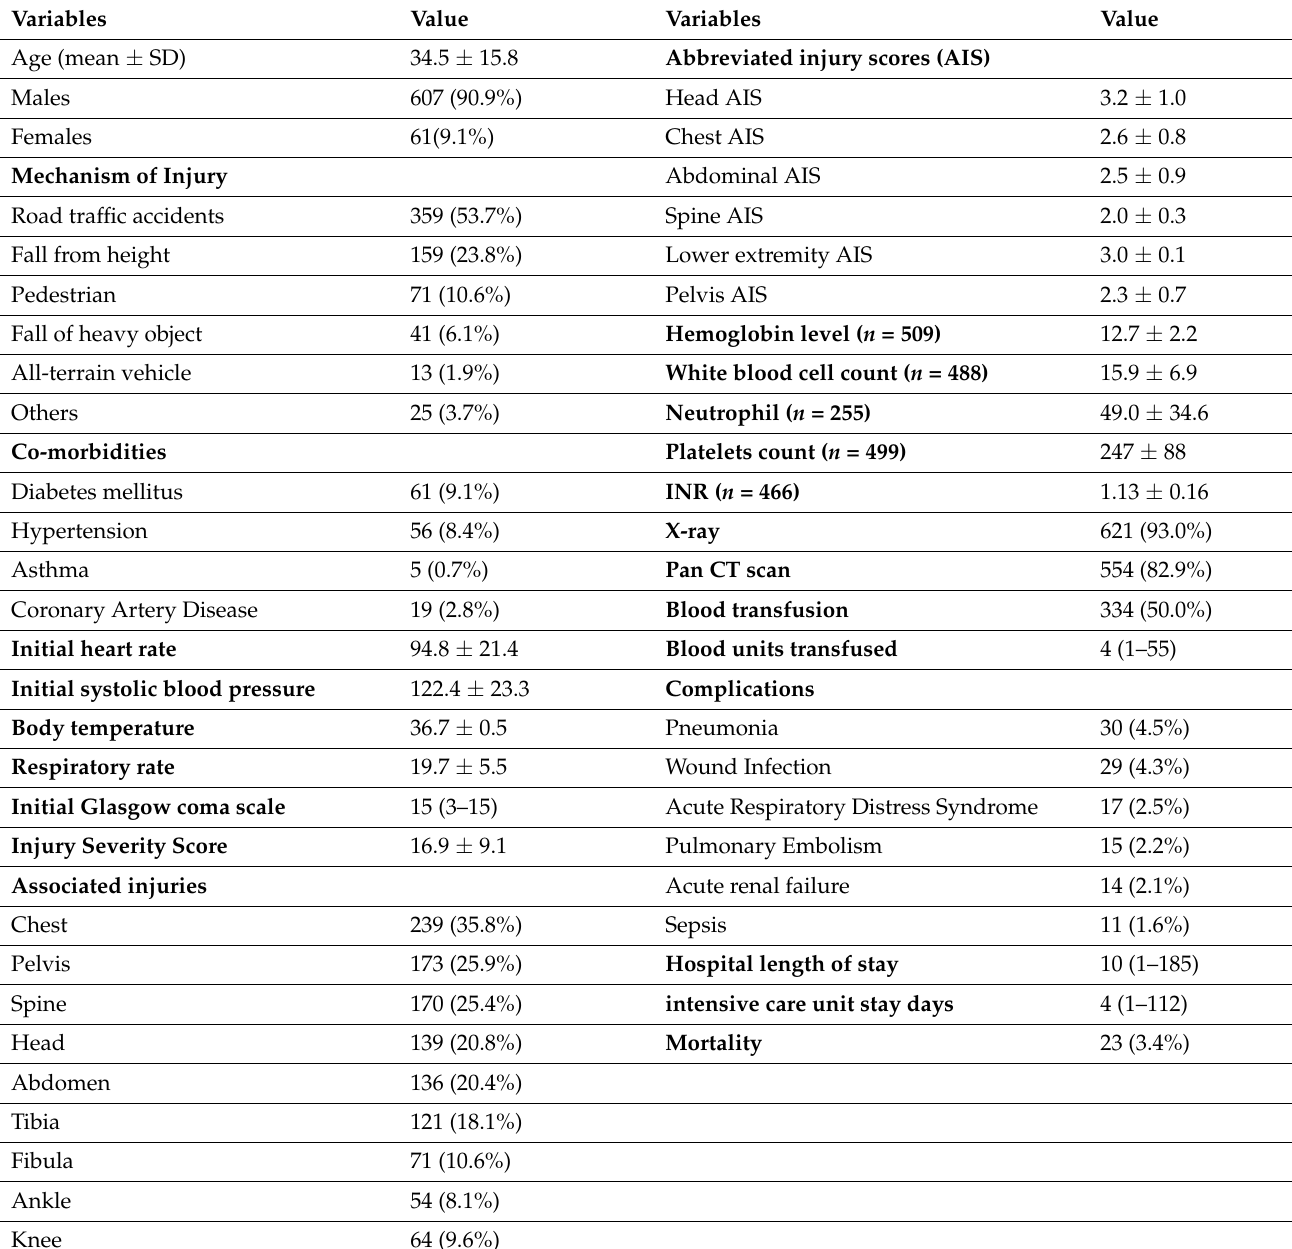
Table 1. Demographics and clinical characteristics, complications and outcome of patients with traumatic femur fracture (January 2016–September 2020) n =